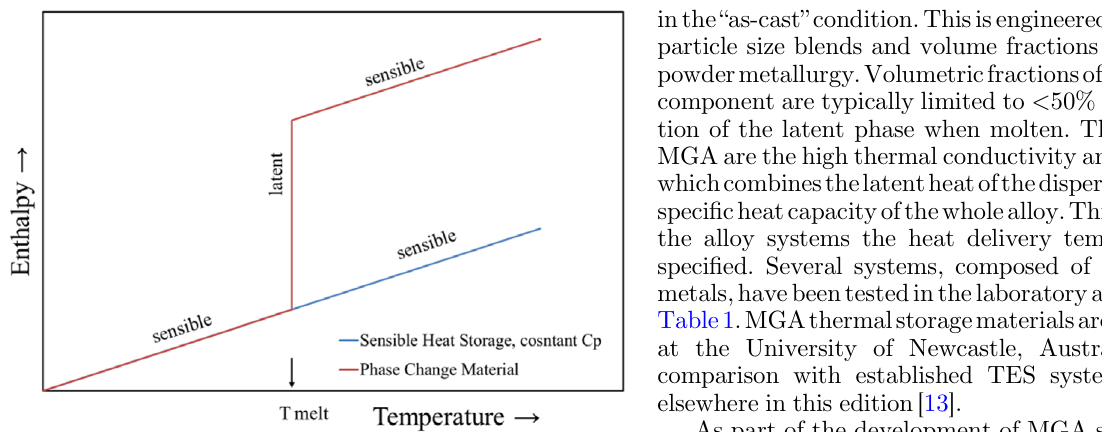
Fig. 1. Idealized enthalpy content with changes in temperatures for sensible and latent heat storage materials (adapted from [8]).